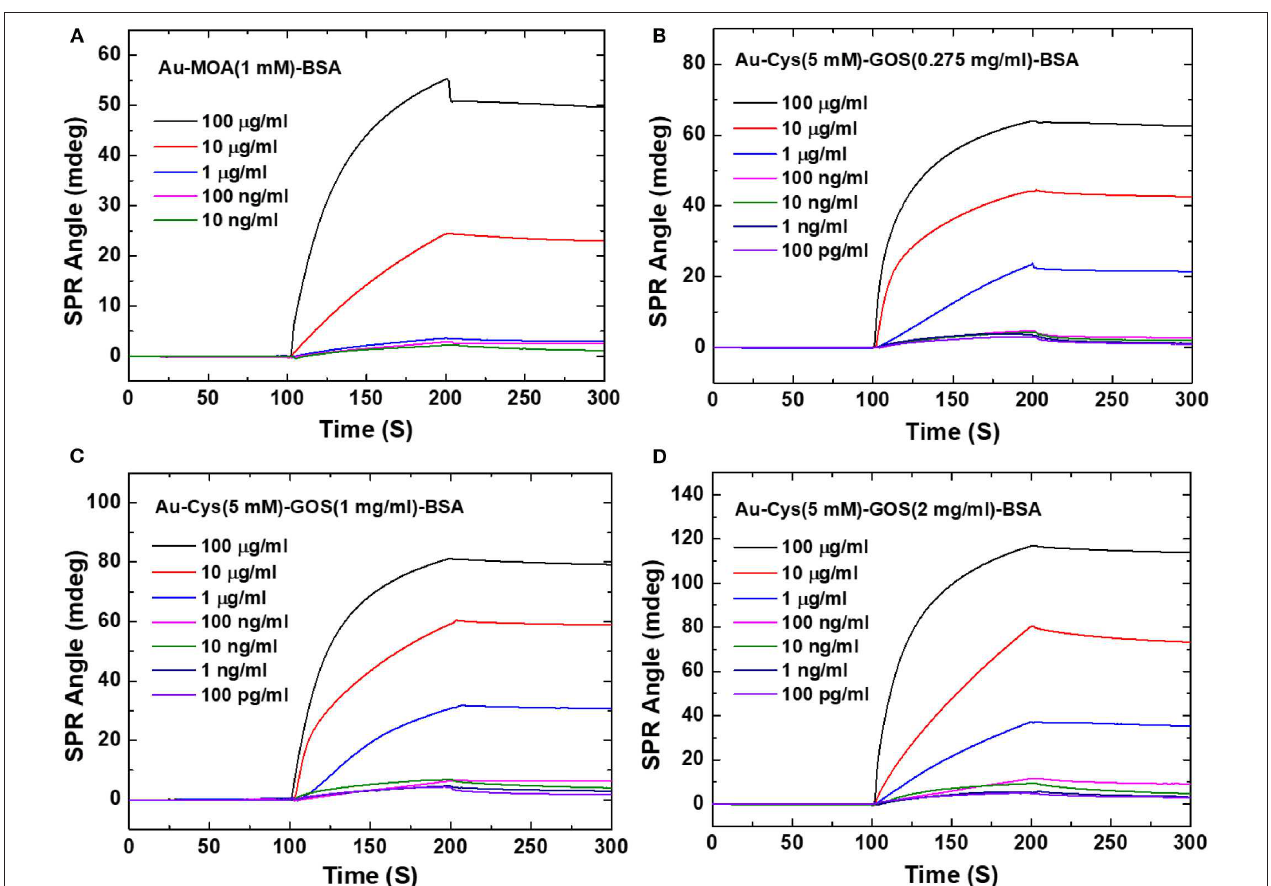
FIGURE 3 | Surface plasmon resonance sensograms obtained in response to BSA solutions of different concentrations flowing over the surfaces of the sensors. (A) Interaction with the conventional Au film-based (Au–MOA) sensor (1mM). (B) Interaction with the 0.275 mg/mL GOS. (C) Interaction with the 1 mg/mL GOS sensor. (D) Interaction with the 2 mg/mL GOS sensor. Figures (A–D) were reproduced from Chiu and Huang (2014) with permission from Elsevier. Copyright 2014,